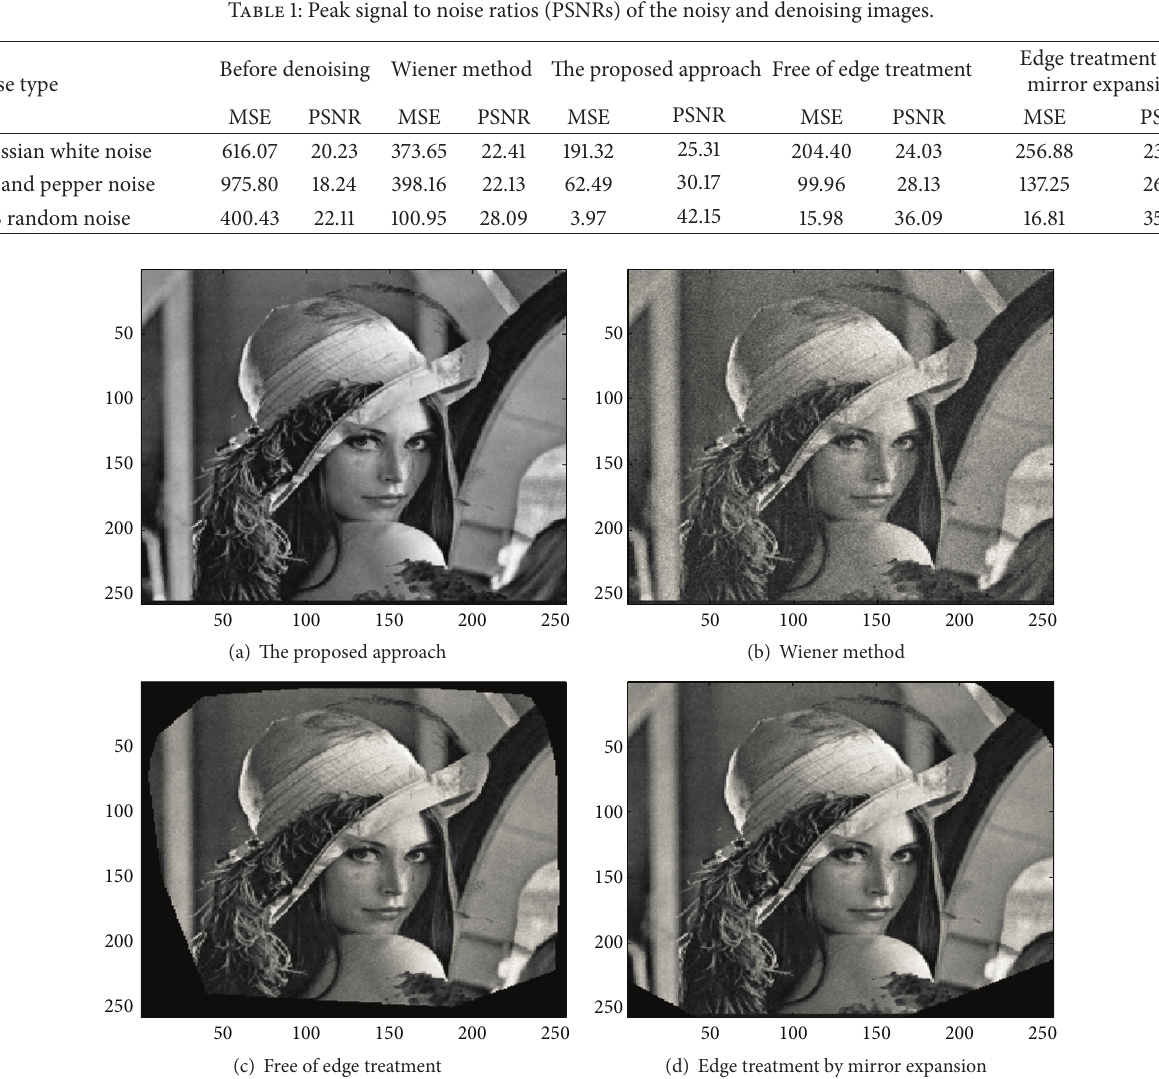
Figure 7: Comparison of denoising results for the image with 20% random